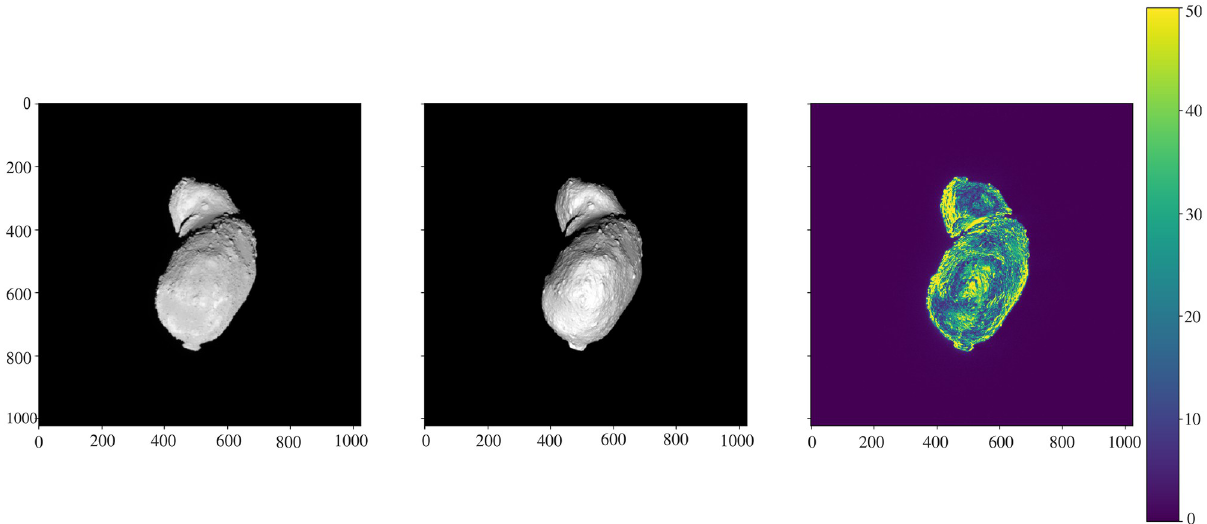
Fig 6. The pixel-by-pixel comparison of the original AMICA image on the left and generated Cycles image in the middle. The scale indicates percent error. The AMICA image is published under Public Domain 1.0.